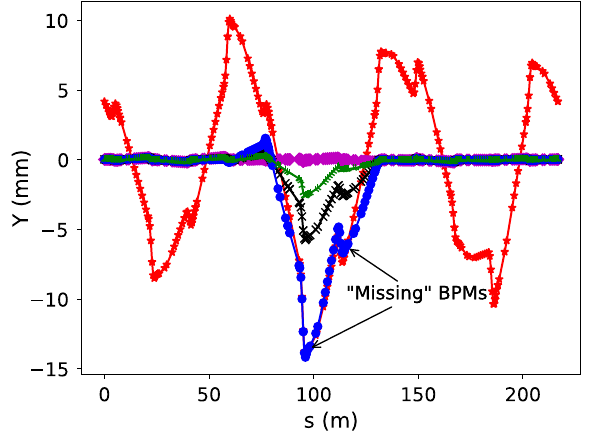
FIG. 11. Measured horizontal closed orbits in SIS18 for the various average momentum offsets represented as percent with each